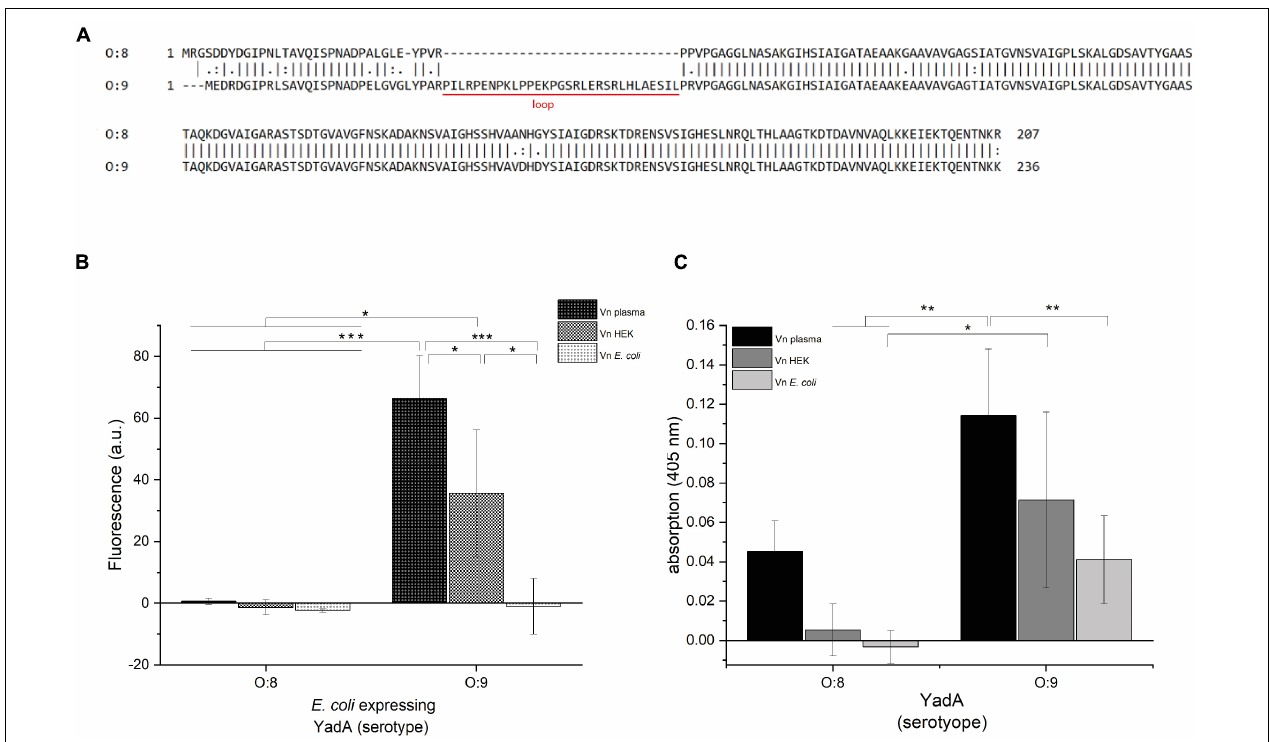
FIGURE 1 | YadA O : 9 binds to Vn plasma and Vn HEK but shows reduced binding to Vn Ec . (A) Alignment of the N-terminal head domains of the YadA head domain from Y. enterocolitica serotypes O:8 and O:9. The alignments include the head domain of YadA, the neck region, and the first 20 residues of the coiled-coil stalk domain. YadA O : 9 has an insertion of 31 residues toward the N-terminus of the head domain. (B) Whole-cell binding assay to Vn using E. coli expressing either YadA O : 8 or